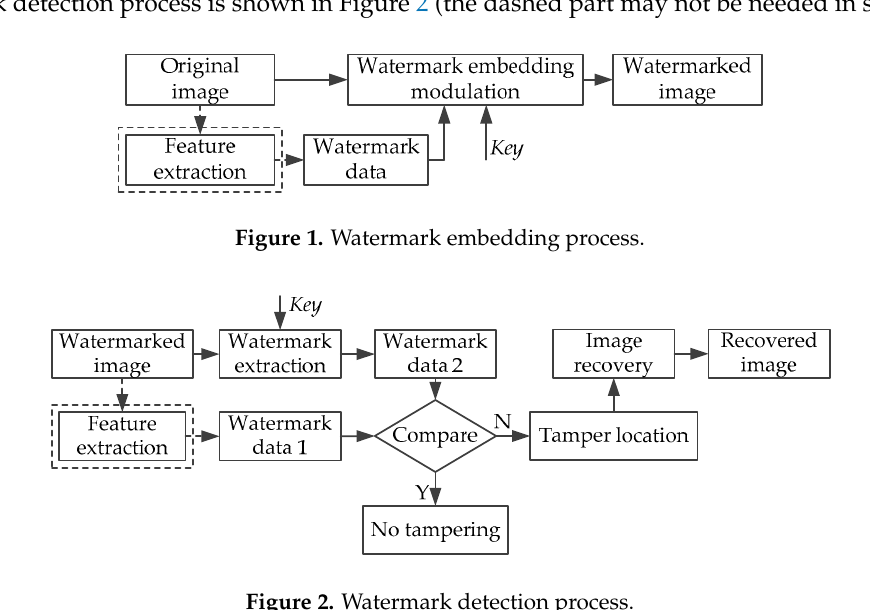
Figure 2. Watermark detection process.